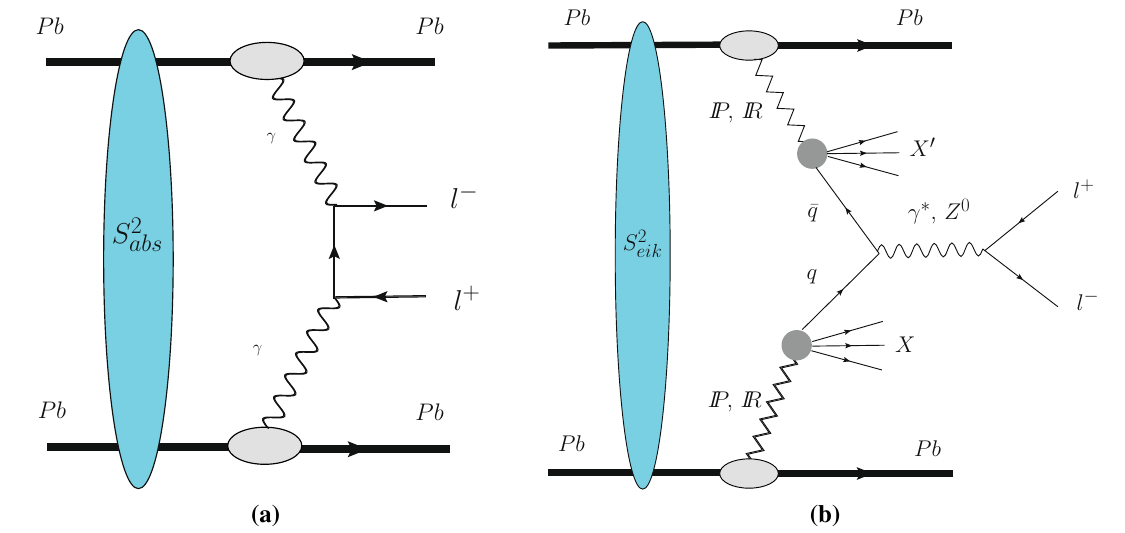
Fig. 1 Dilepton production in a exclusive and b diffractive interactions considering PbPb collisions at the